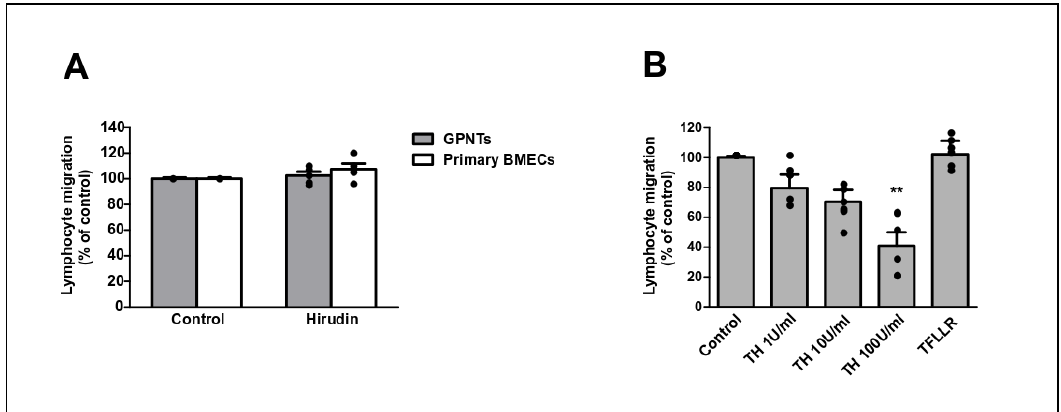
Figure 3. Thrombin does not activate TEM. ( A ) GPNT or primary BMVECs and PAS were pre-treated for 1 h with Hirudin (20 U/mL) and then combined for 4 h TEM assays. ( B ) GPNT were pre-treated for 1h with the indicated concentrations of thrombin or the PAR-1 TFLLR agonist before PAS were added and 4 h TEM assessed. Data represented as normalised means −/+ SEM. Each data point represents one independent, biological replicate. Significant differences from controls were determined ANOVA and Dunnett’s post-hoc analysis with ** p < 0.01 (vs. control).